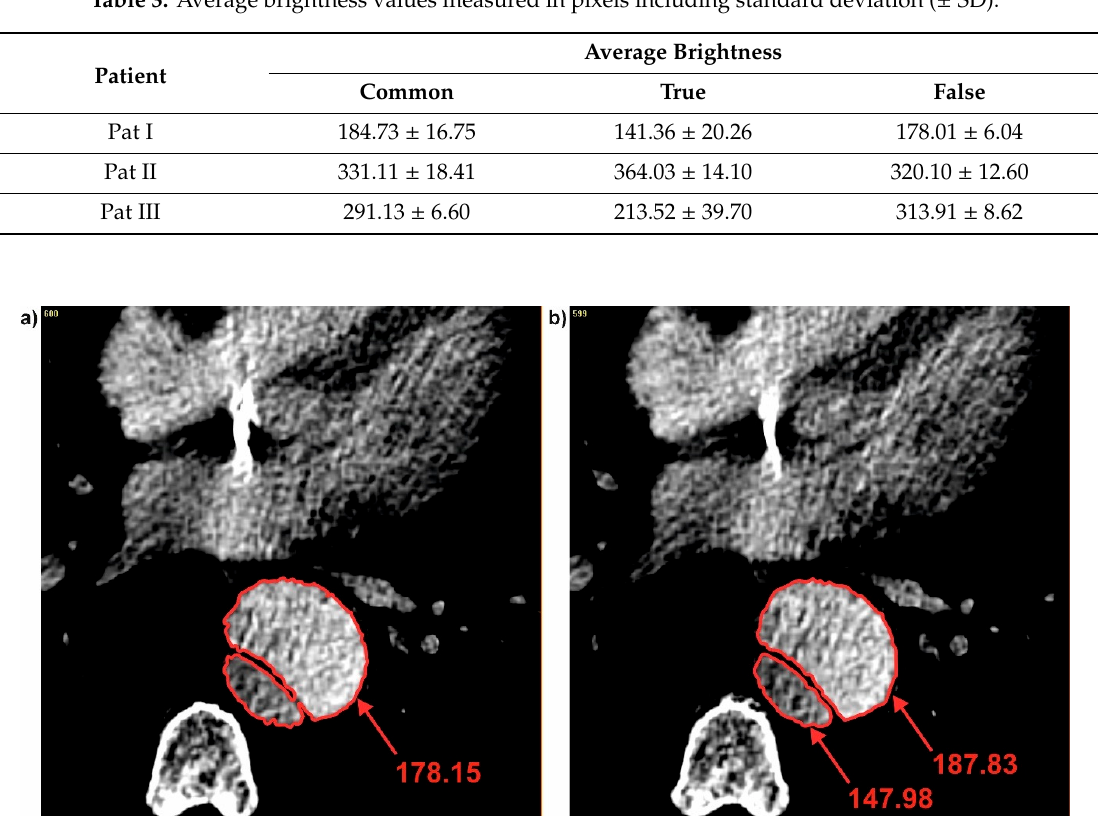
Table 3. Average brightness values measured in pixels including standard deviation ( ± SD).